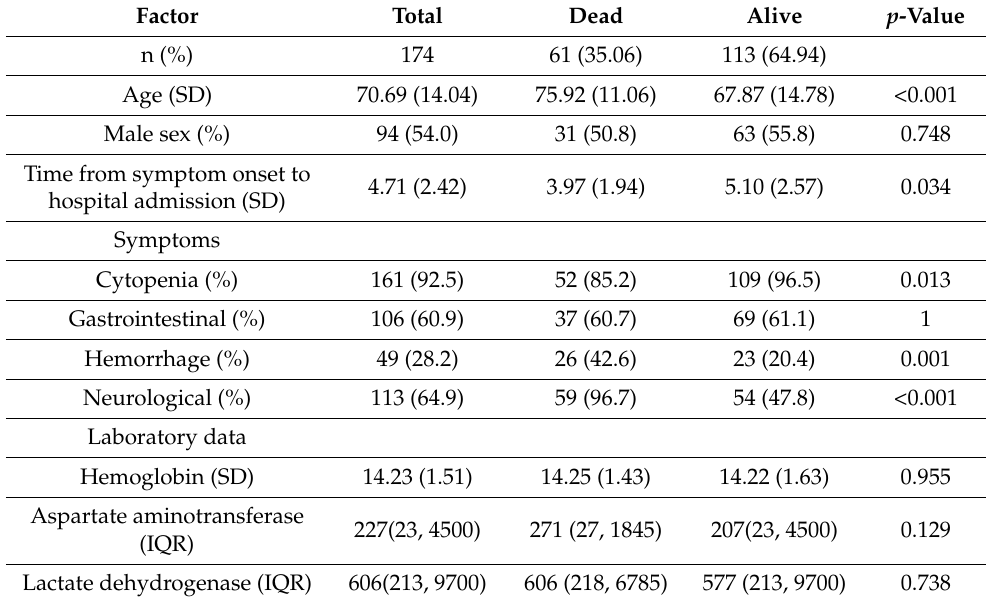
Table 1. Demographic data of the included cases.